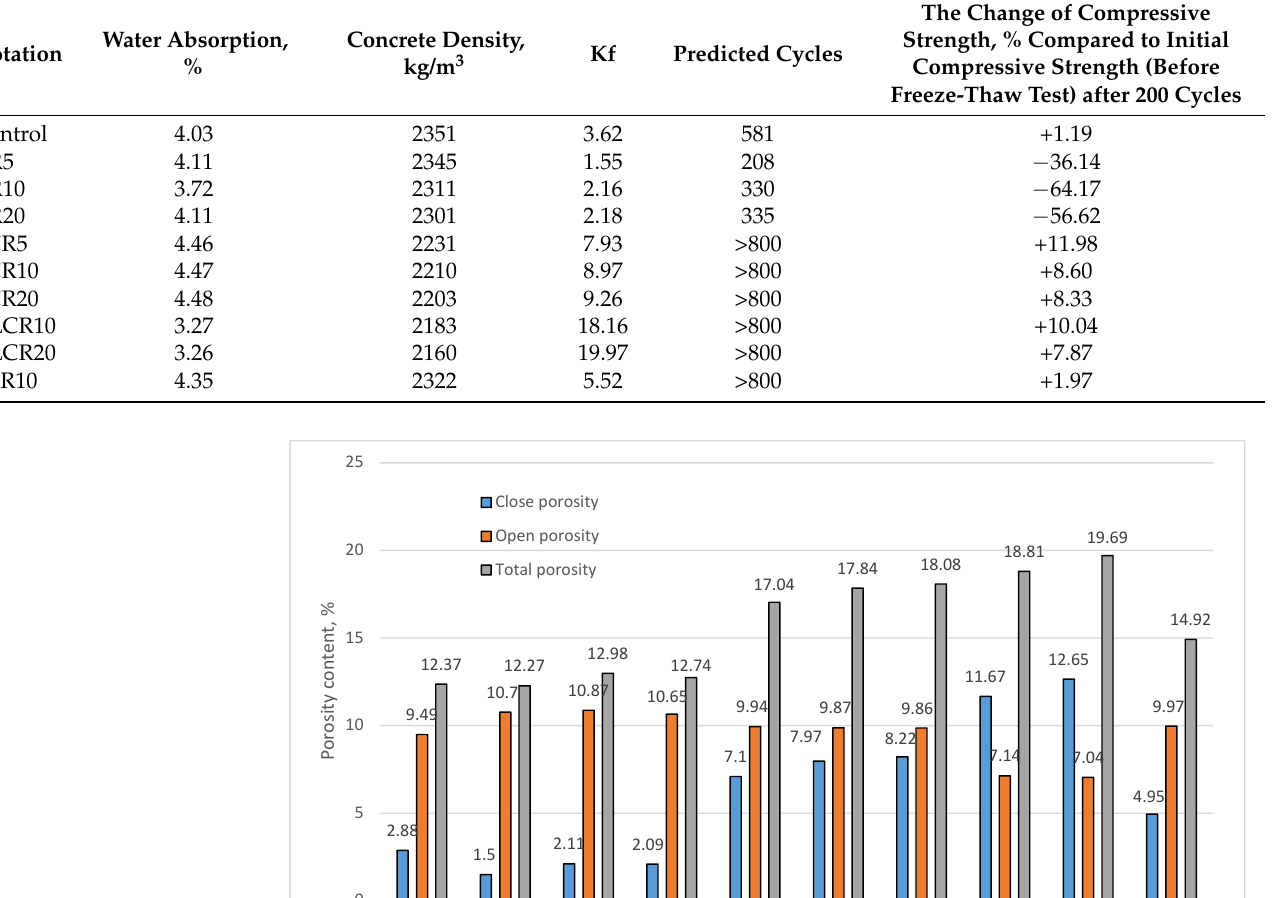
Table 5. Durability parameters of hardened concrete.